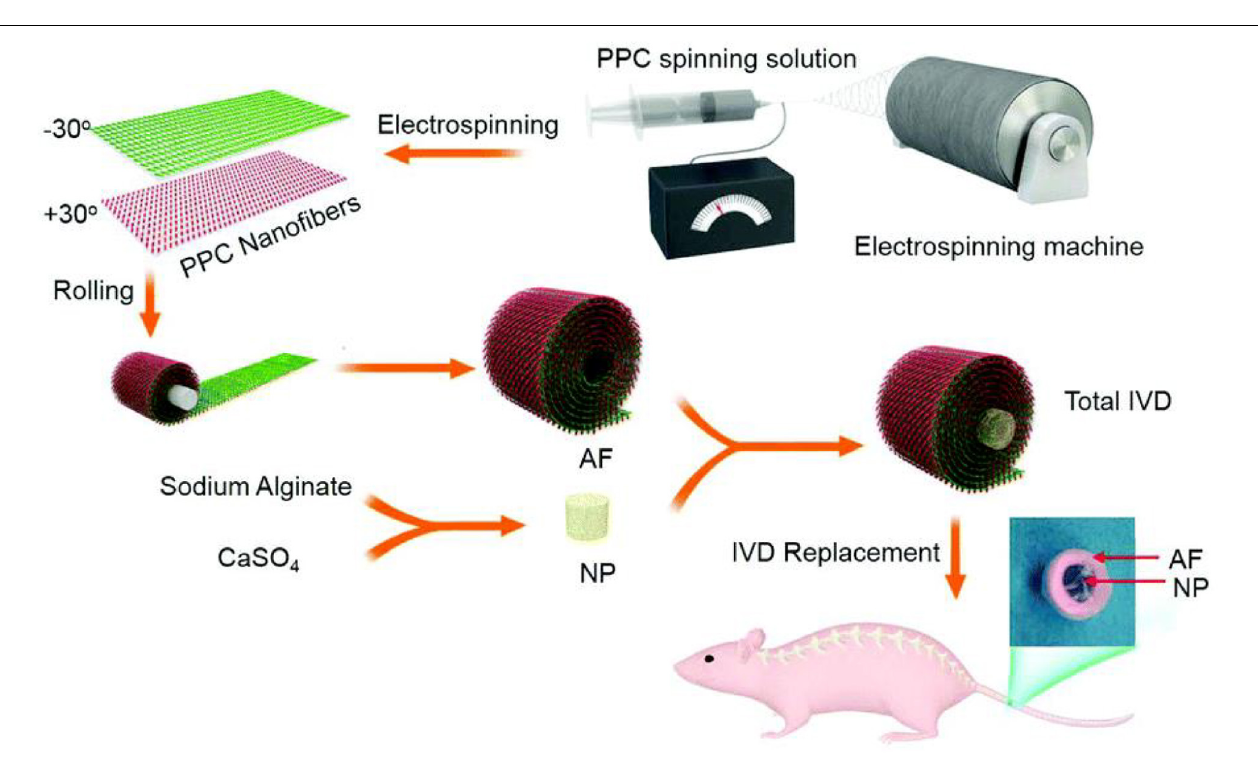
FIGURE 8 | Schematic illustration of the procedure of IVD preparation and replacement using blended PCL/PLGA/type I Collagen spinning solution. Reproduced from Yang et al. (2017) with permission from Copyright 2017 Royal Society of